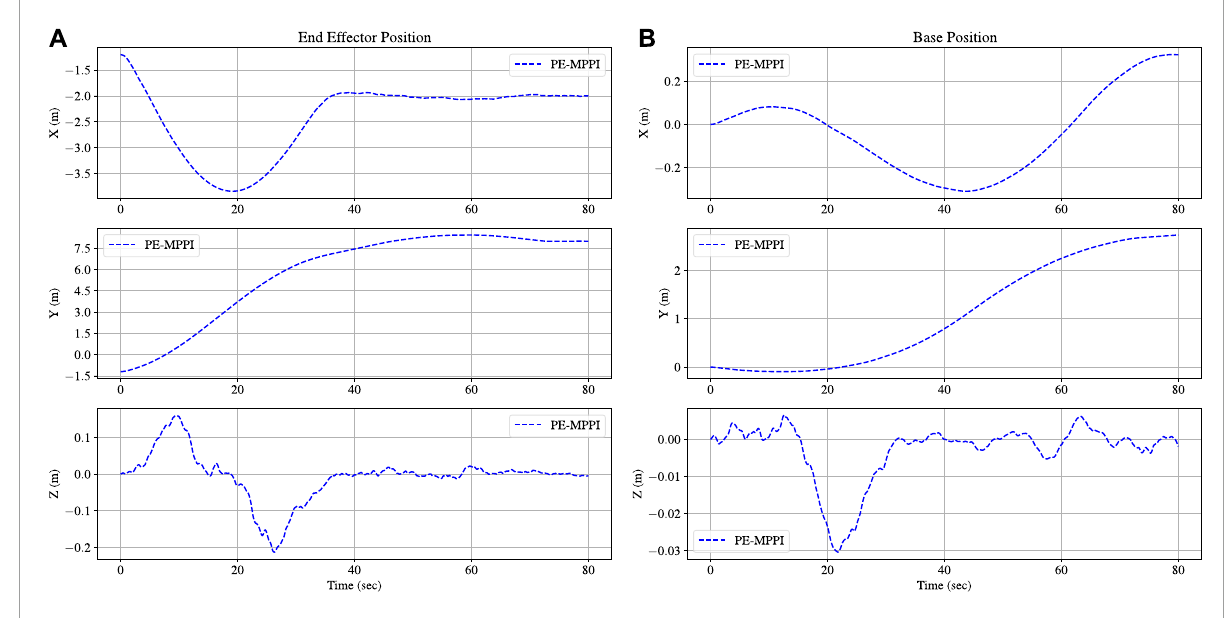
FIGURE 5 The position of the end-effector reaches the target position after 60 s in the normal operation scenario (A) . The space robot base position is traversed along the y-orbit (B) .